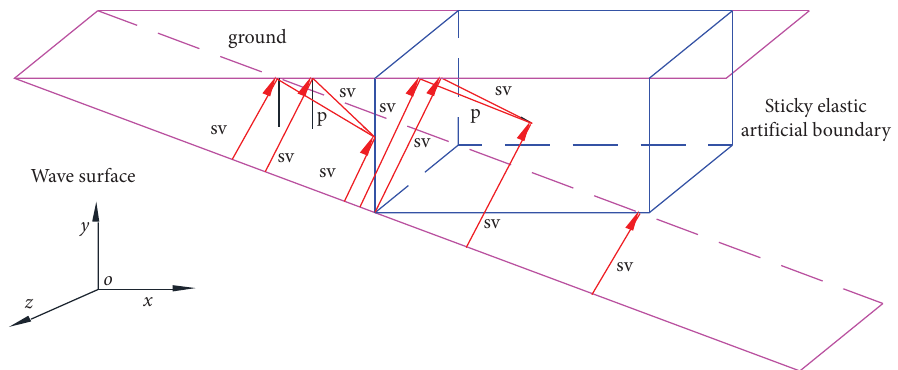
Figure 2: SV wave oblique incidence